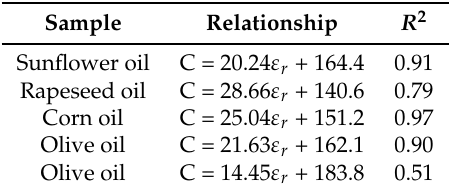
Table 3. Correlation between relative permittivity ε r and the measured capacitance using the IDE sensor and the measurement circuit.